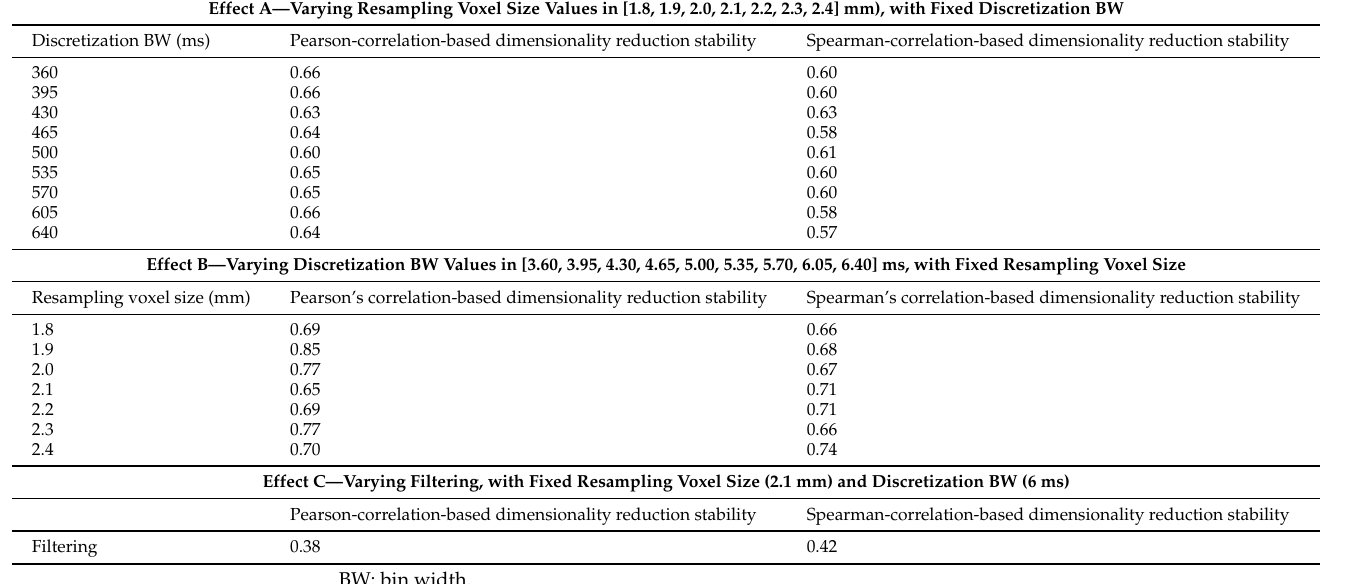
Table 3. Stability indices for T1